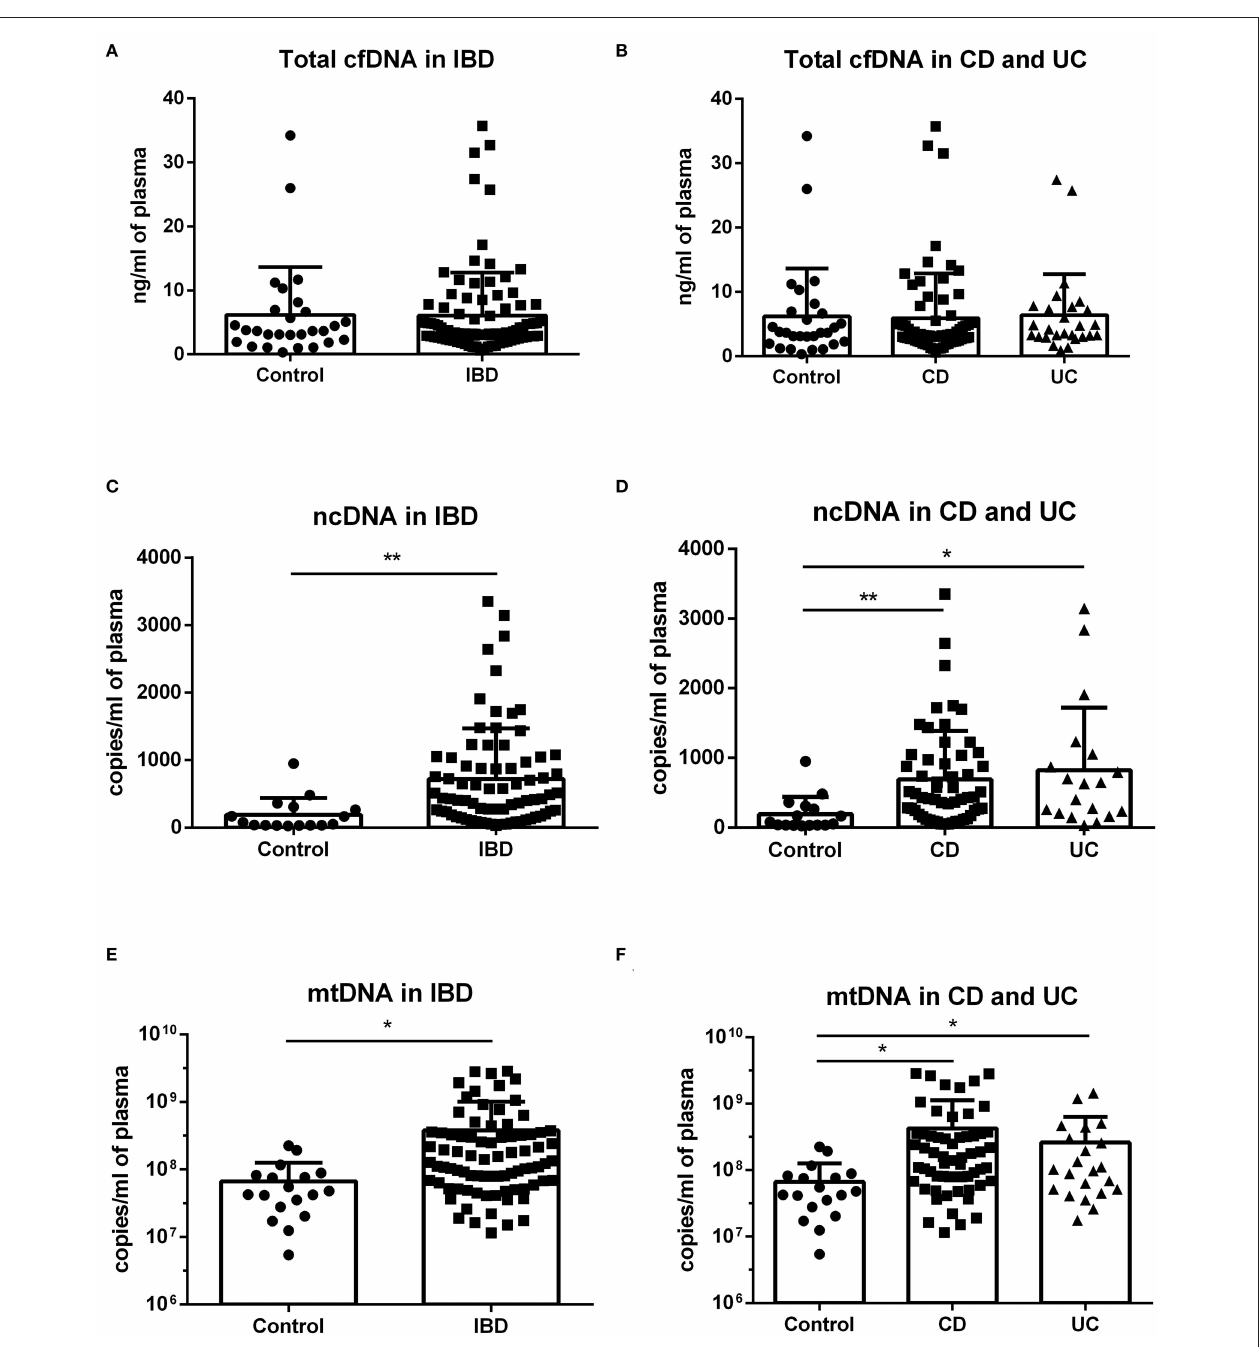
FIGURE 1 | Concentration of total cfDNA, ncDNA and mtDNA in IBD patients and controls. No difference in total cfDNA between healthy controls and patients was found (A,B) . IBD patients showed higher levels of both ncDNA and mtDNA compared to healthy controls ( C : p = 0.0061 and E : p = 0.0387). The difference was also seen in both subgroups of CD and UC patients ( D : p = 0.0062 for CD and 0.0105 for UC against control and F : p = 0.0345 for CD and p = 0.0365 for UC against control). * P < 0.05, ** P < 0.01.